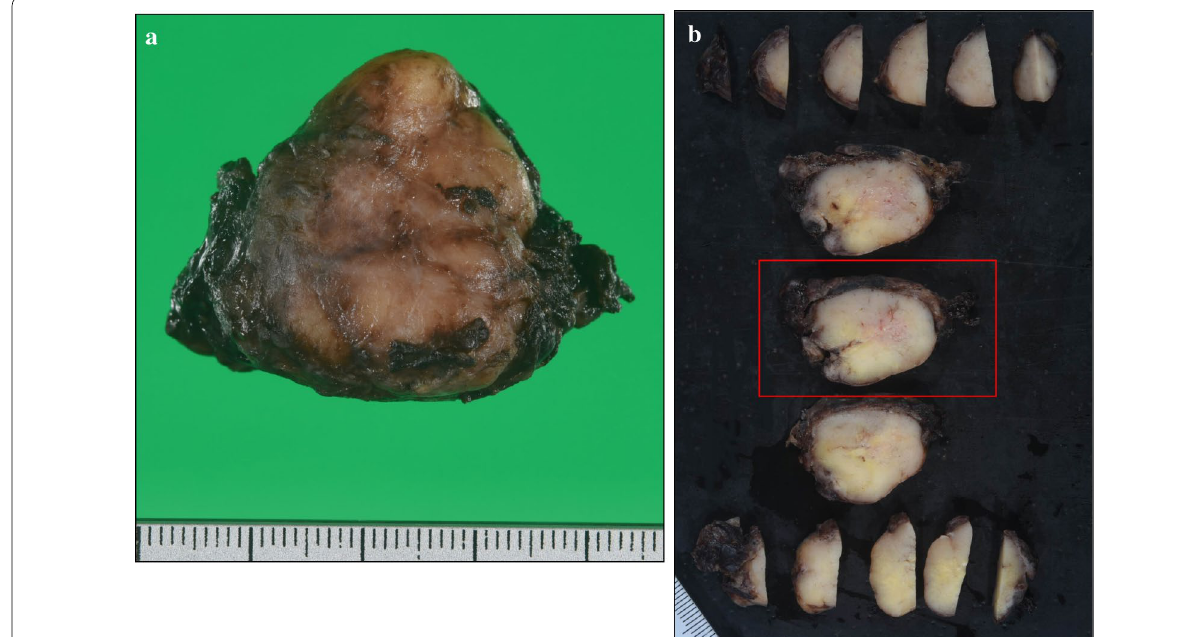
Fig. 2 Macroscopic appearance. Tumor was 3.5